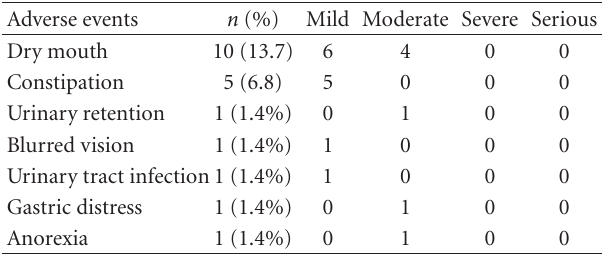
Table 3: Adverse events in 73